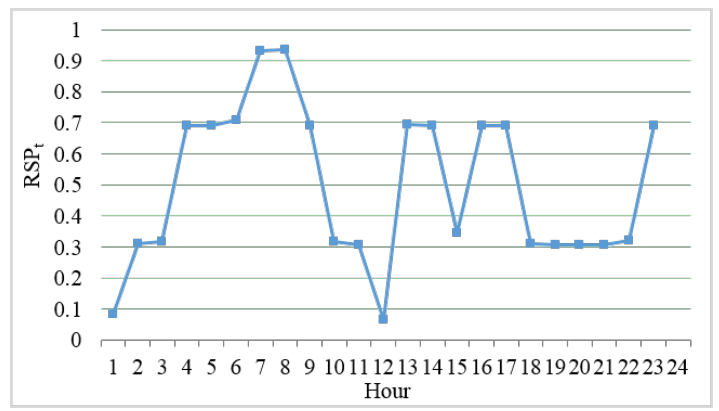
Figure 4. RSP t on the peak-load day in 2016.